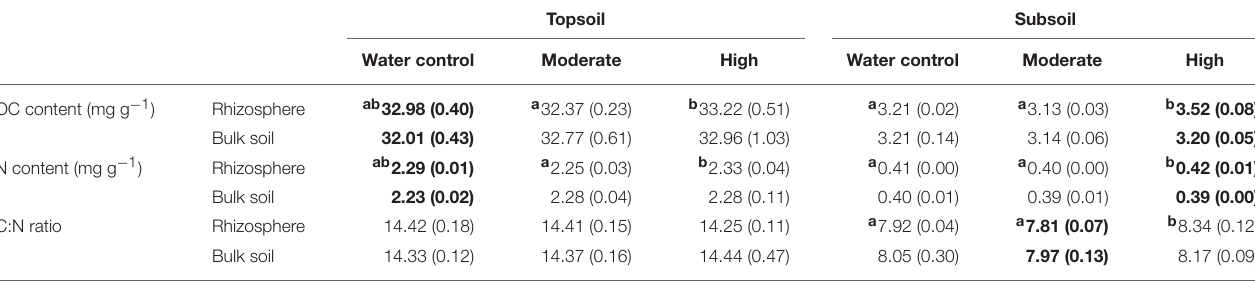
TABLE 3 | Organic carbon (OC) and nitrogen (N) contents and the C/N ratio.